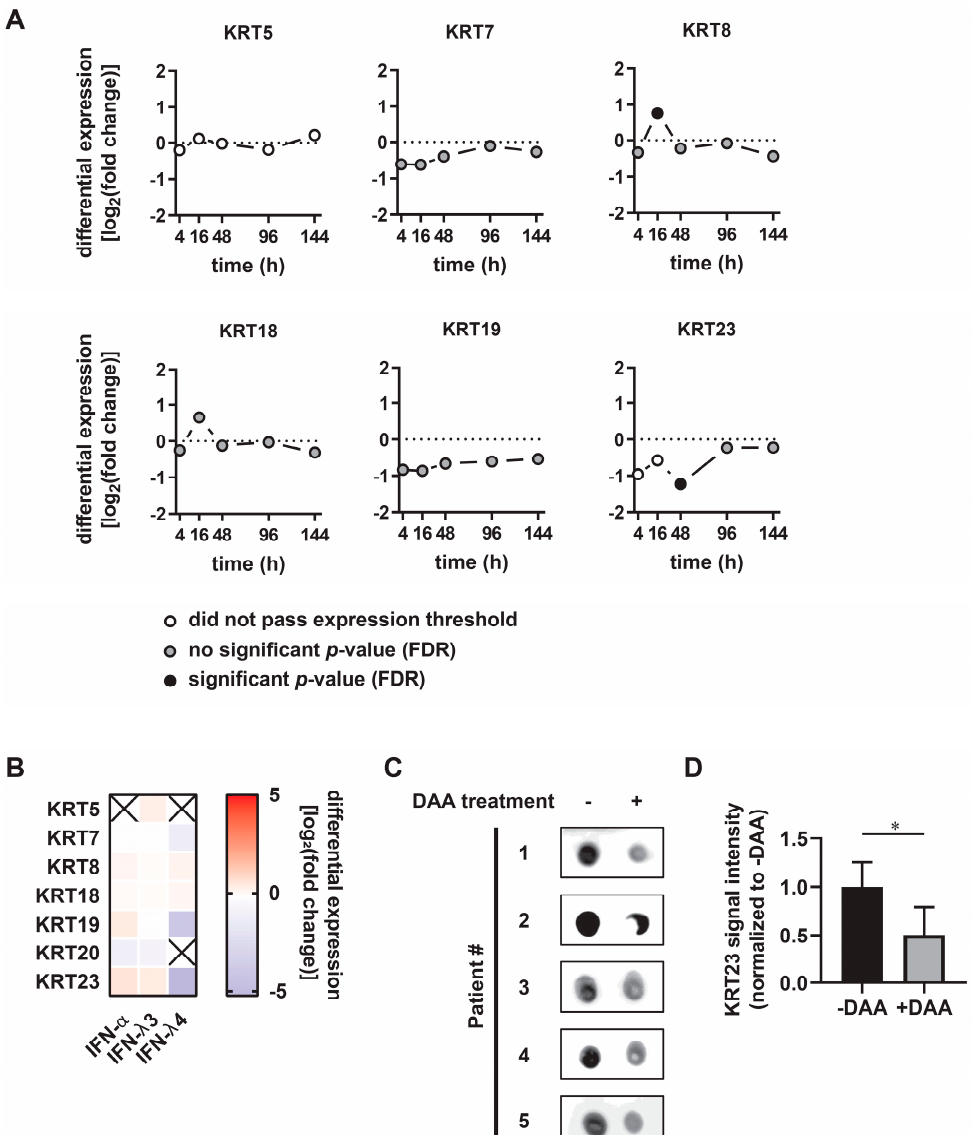
Figure 3. Keratin 23 serum levels decrease in response to direct-acting antiviral (DAA)-mediated viral clearance. ( A ) Keratin expression levels of pre-treatment and post-treatment liver biopsies of chronic hepatitis C patients at indicated time points after PEGylated interferon- α / ribavirin treatment. Raw data were obtained from Boldanova et al. [30]. ( B ) Heatmap of mRNA expression levels of keratins in primary human hepatocytes (PHHs) upon IFN- α (100 IU / mL), IFN- λ 3 independent donors 6 h post-treatment. mRNA. ( C ) Keratin 23 sera levels of chronic hepatitis C patients ( n = 5) pre- and post-DAA therapy. Patient sera, obtained prior to DAA treatment and post-viral clearance were assessed for the keratin 23 content via dot blot analysis. ( D ) Quantification of keratin 23 signals of the dot blot analysis (C). Keratin 23 level prior to DAA treatment was arbitrarily set as one. Shown are mean values ± standard deviation from five donors (unpaired two-tailed Student’s t -test; * p < 0.05).